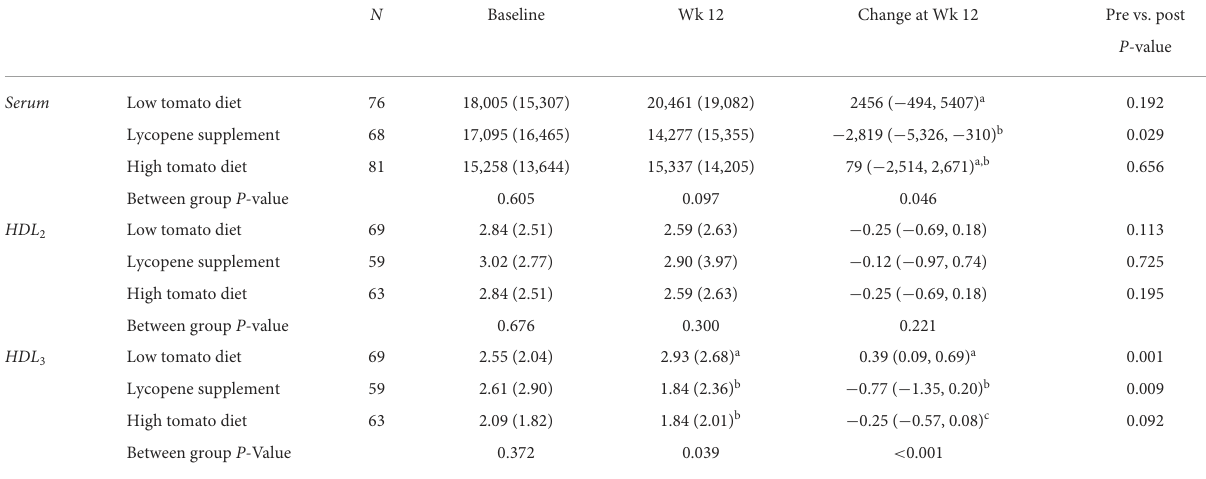
TABLE 7 SAA concentration in serum, HDL 2 , and HDL 3 following 12-week intervention with either a low tomato diet, lycopene supplement, or high tomato